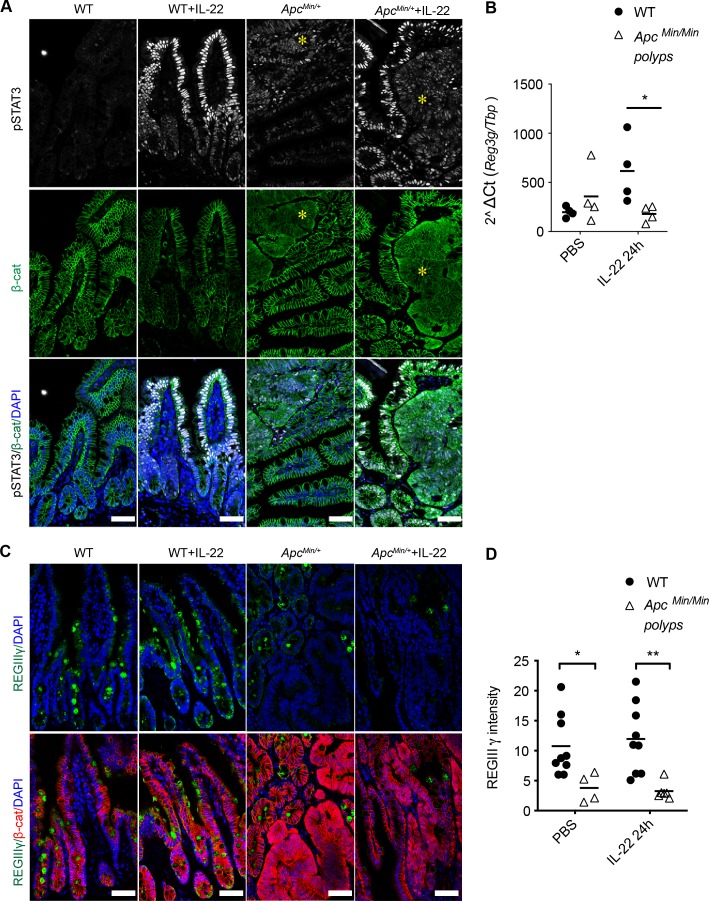
Reduced IL-22 responses in cells in ApcMin/Min small intestinal polyps in vivo.Mice aged between 88 and 95 days were injected i.p. with 1 μg IL-22 or PBS. (A) Small intestine was harvested after 1 hour and tissue stained with antibodies against pSTAT3 (Tyr705) and β-catenin. Nuclei were stained with DAPI. Asterisk indicate polyps. (B) Small intestine was harvested 24 hours after IL-22 injection. RNA was isolated, and RT-qPCR was performed. Data show the level of Reg3g mRNA relative to Tbp. *P < 0.05, two-way ANOVA. (C) Small intestine was harvested 24 hours after IL-22 injection, and IHC was performed using antibodies against RegIIIγ and β-catenin. Nuclei were stained with DAPI. Three independent experiments were performed. Number of mice used in total: WT = 3; ApcMin/+ = 6. Scale bar = 50 μm. (D) Mean fluorescence intensity for RegIIIγ in the epithelial area analysed using Fuji software. Each dot represents the mean fluorescence intensity in 1 confocal image. *p < 0.05, **p < 0.01, t test. Numerical values for (B) and (D) are available in S1 Data. β-cat, β-catenin; Apc, adenomatous polyposis coli; DAPI, 4',6-diamidine-2'-phenylindole dihydrochloride; IHC, immunohistochemistry; IL-22, interleukin-22; i.p., intraperitoneal; pSTAT3, phosphorylated signal transducer and activator of transcription 3; Reg3g or RegIIIγ, Regenerated islet-derived protein 3 gamma; RT-qPCR, quantitative reverse transcription polymerase chain reaction; Tyr705, Tyrosine 705; WT, wild type.